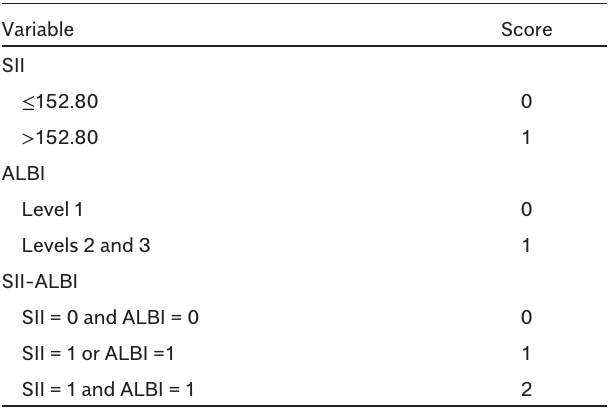
SII-ALBI, systemic immune-inflammation index along with albumin-bilirubin